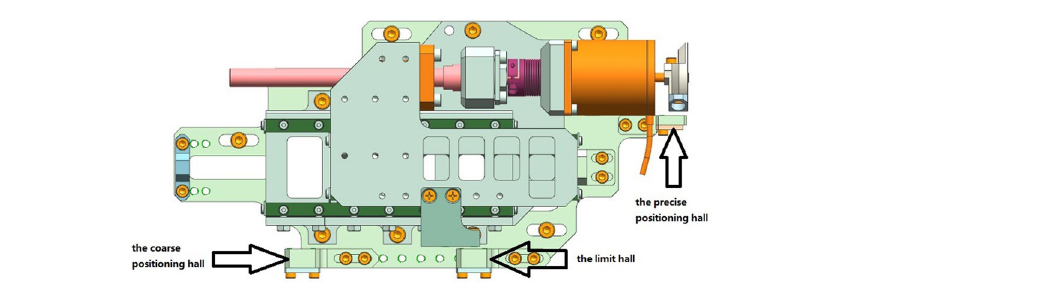
Figure 3. Hall’s position diagram of scanning